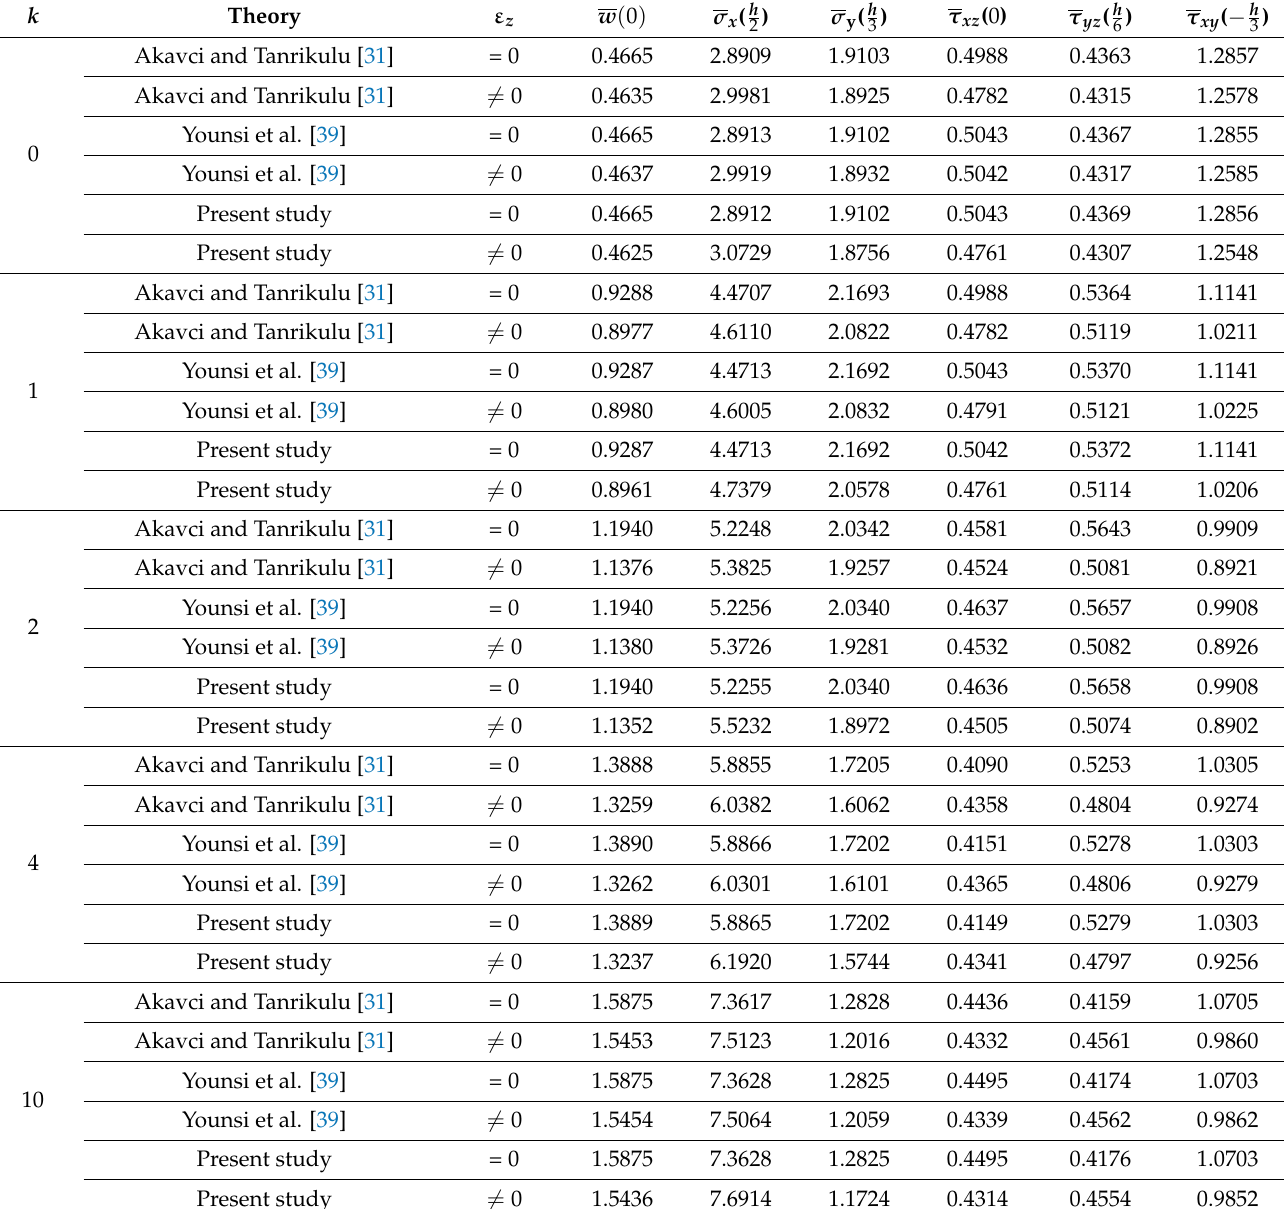
Table 2. The non-dimensional displacement and stress components of an Al/Al 2 O 3 FG square plate subjected to uniformly distributed load ( a / h =